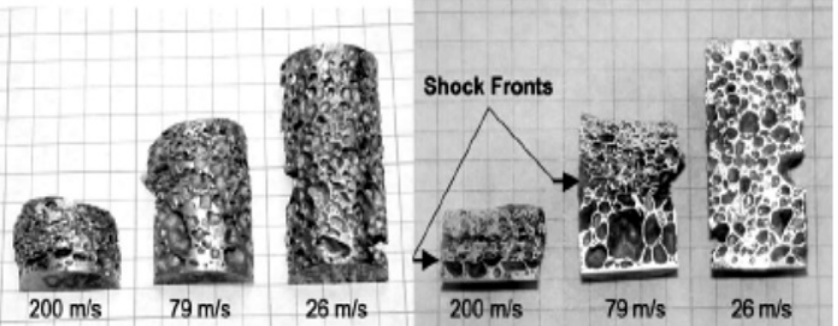
Figure 2: Cells collapse in impact loading [10].